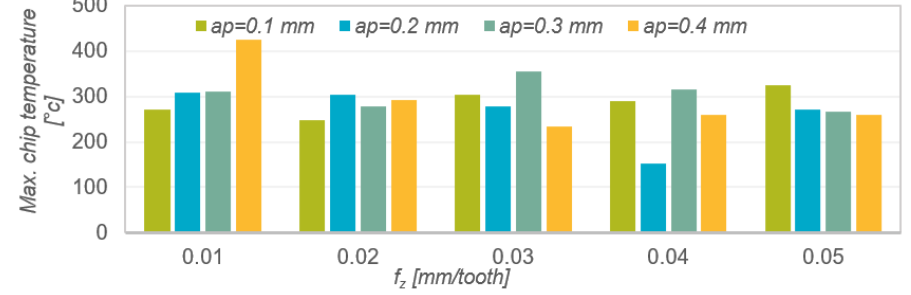
Figure 9. Results of measurements of the chips’ maximum temperature as a function of feed per tooth and depth of cut. tooth and depth of